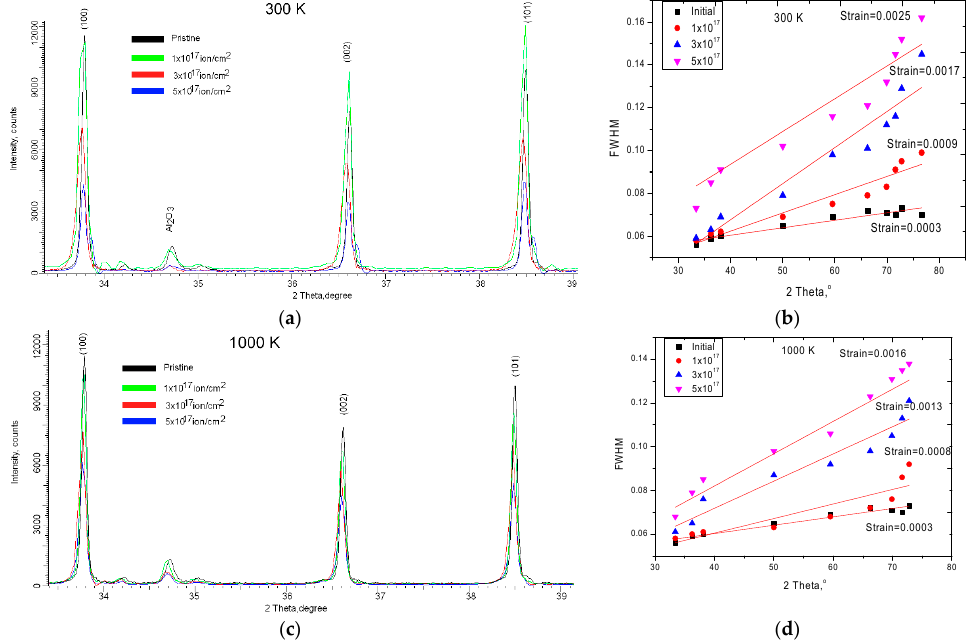
Figure 7. ( a , c ) X-ray diffraction patterns of studied samples; ( b , d ) construction of Williamson–Hall. As can be seen from the presented data, for the samples irradiated at a temperature of 300 K at a fluence of irradiation of 1.0 × 10 17 ion/cm 2 there was a slight change in the intensity of the diffraction maxima, as well as the broadening of the diffraction lines. A slight displacement of the maxima in the